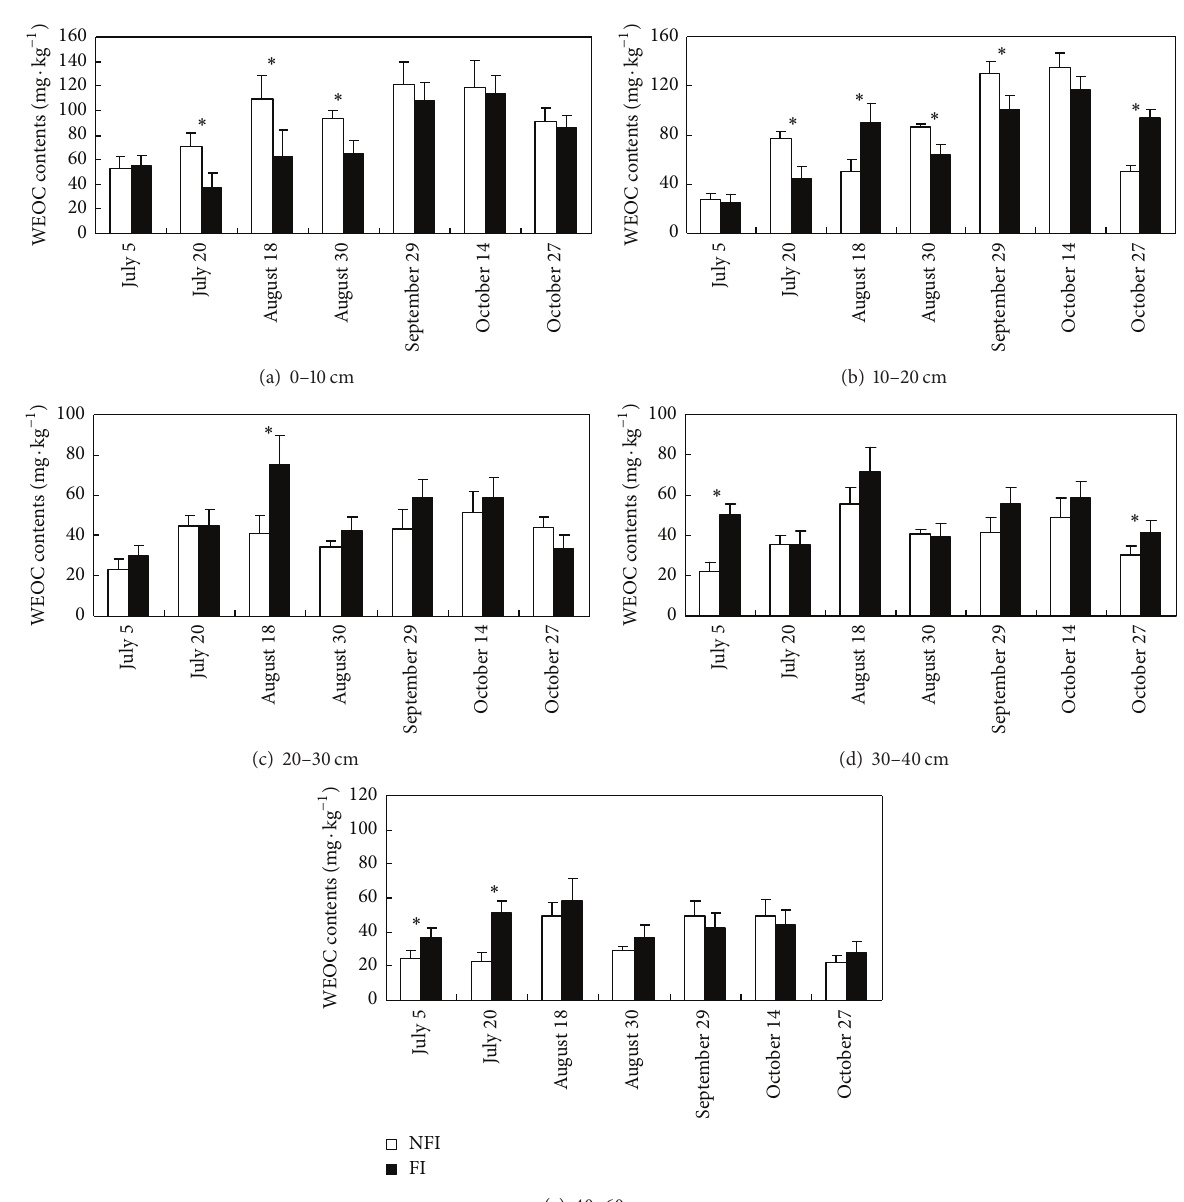
Figure 3: Water extractable organic carbon (WEOC) contents in paddy soils under different irrigation managements ( ∗ indicates difference between NFI and FI that is significant at 𝑃 < 0.05 ). large reduction in water consumption and irrigation